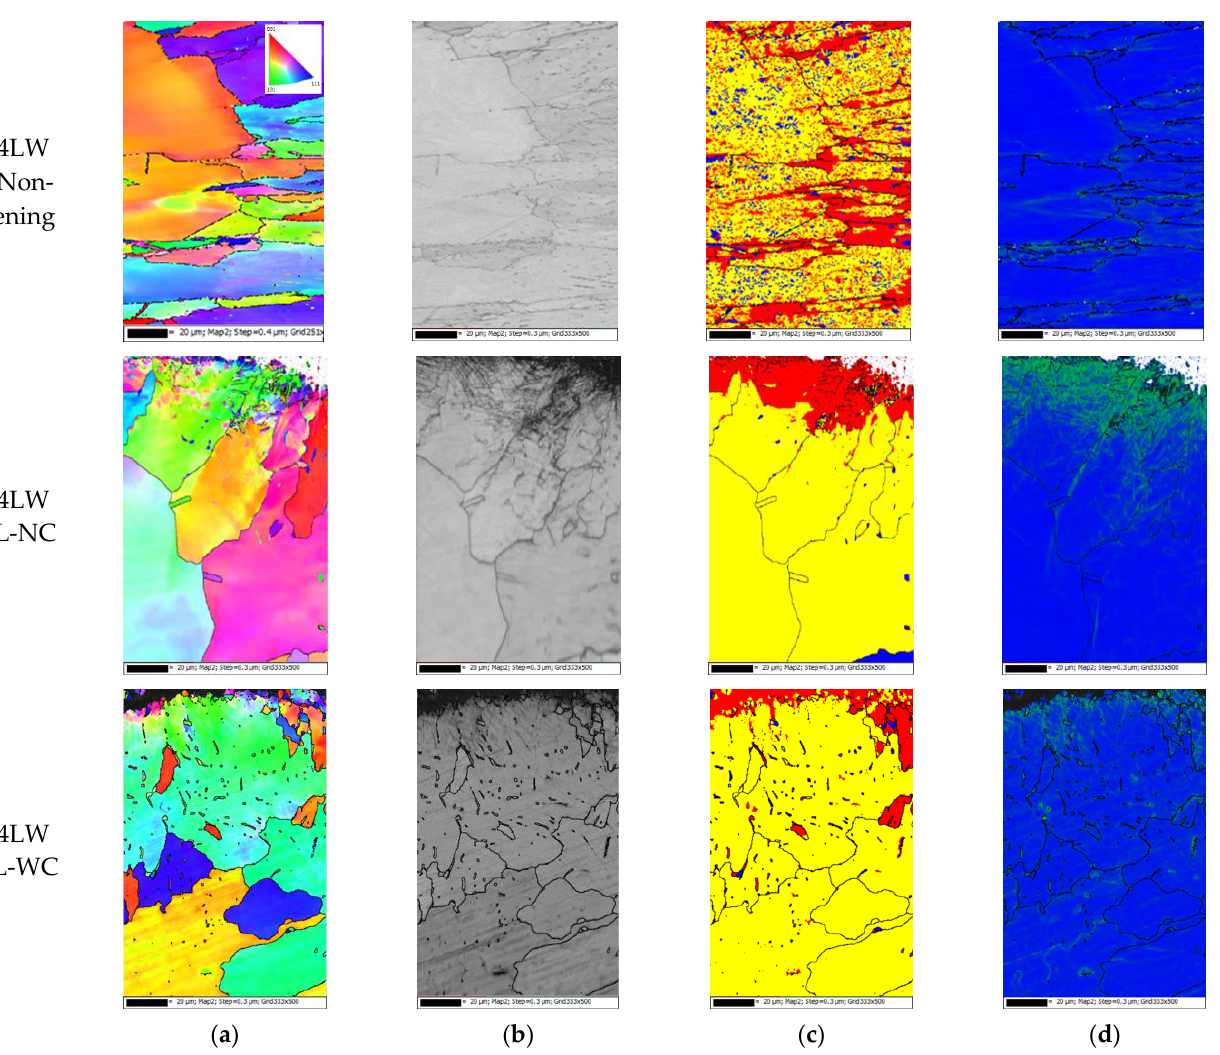
Figure 11. EBSD results of 304L HAZ area after laser peening (EBSD: step size 0.3 μm, depth ~150 μm) : ( a ) IPF coloring, ( b ) band contrast, ( c ) recrystallized fraction, and ( d ) dislocation density.